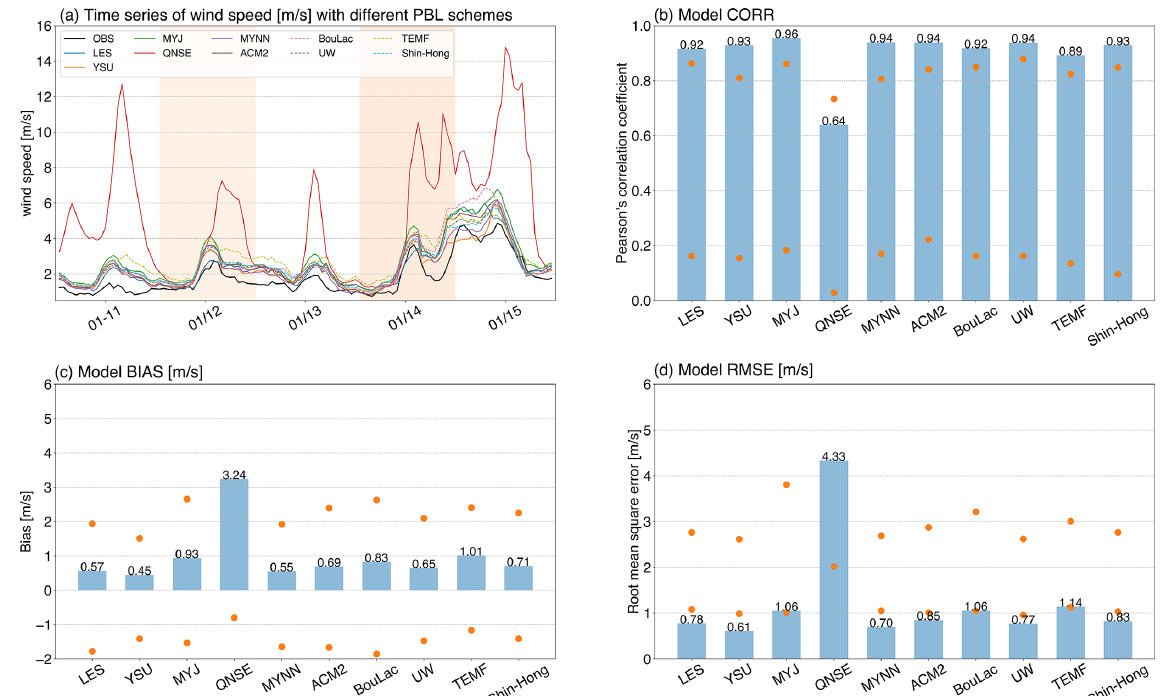
Figure 3. (a) Time series of observed and simulated wind speeds (ms − 1 ) and the corresponding statistics of (b) CORR, (c) , BIAS, and (d) RMSE for the PBL schemes. In panel (a) , the frequency of wind speed is hourly, and the tick marks on the x axis indicate 12:00LT of that day, for each PBL scheme, and the average is calculated over the 105 stations and then over all the simulations with that scheme. The dots in panels (b) – (d) represent the range across the stations, for each station, and the metrics are calculated by averaging all the simulations with the specific PBL